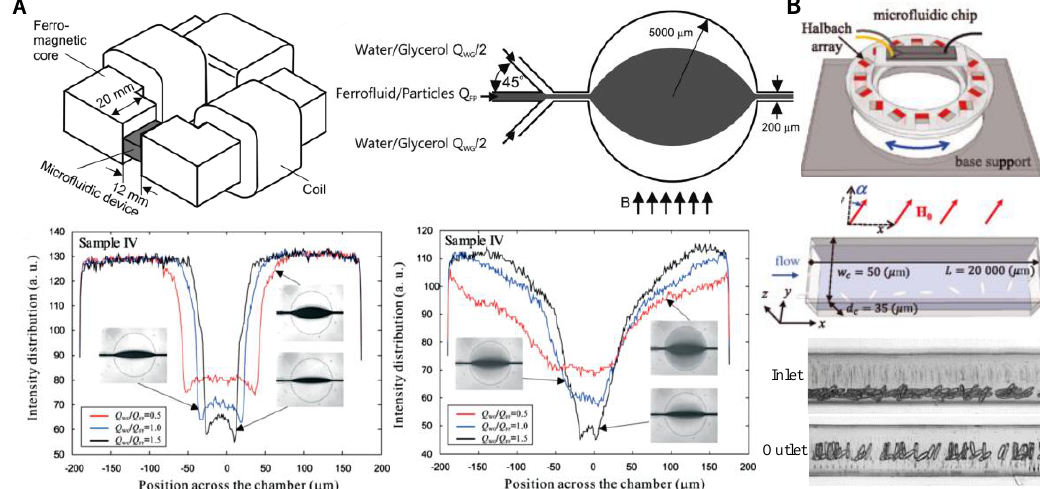
Figure 3. Diamagnetic particle deflection in the flow of magnetic fluids under a uniform magnetic field. ( A ) Experimental setup for the study of migration of diamagnetic beads in a water-sandwiched ferrofluid core flow through a circular chamber in the uniform magnetic field of an electromagnet (top); bead migration-induced ferrofluid spreading (by images and intensity profiles) across the circular chamber when the magnetic field is off and on (bottom). Adapted with permission from Zhu et al. [84], © 2014 The Royal Society of Chemistry. ( B ) Schematic illustration of the microfluidic chip (top) and straight microchannel (middle) in the uniform magnetic field of a Halbach array; superimposed images illustrating the magnetic torque-induced lateral migration of pre-focused ellipsoidal diamagnetic beads in a ferrofluid with a uniform magnetic field perpendicular to the flow (bottom). Adapted with permission from Zhou et al. [74], © 2017 American Physical Society.